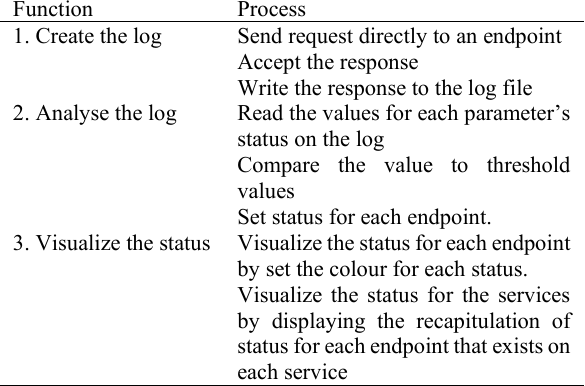
Table 3. Process in DMM Function